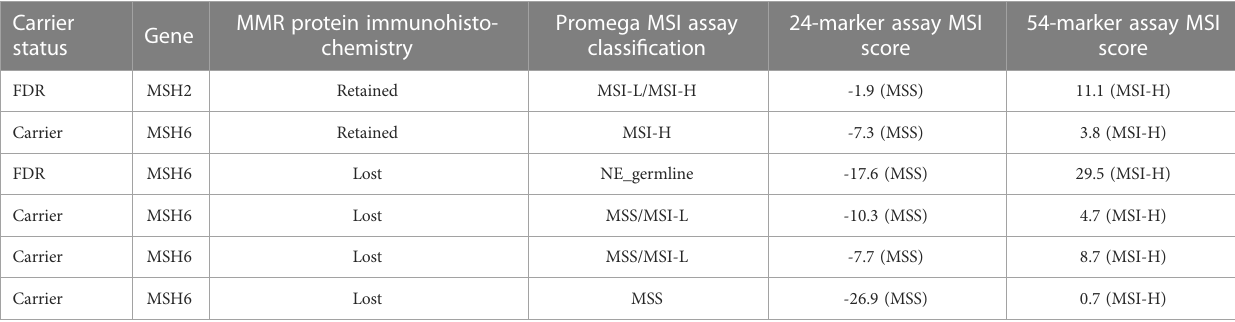
TABLE 3 Overview of the six samples that were discordant with the 24- and 54- marker